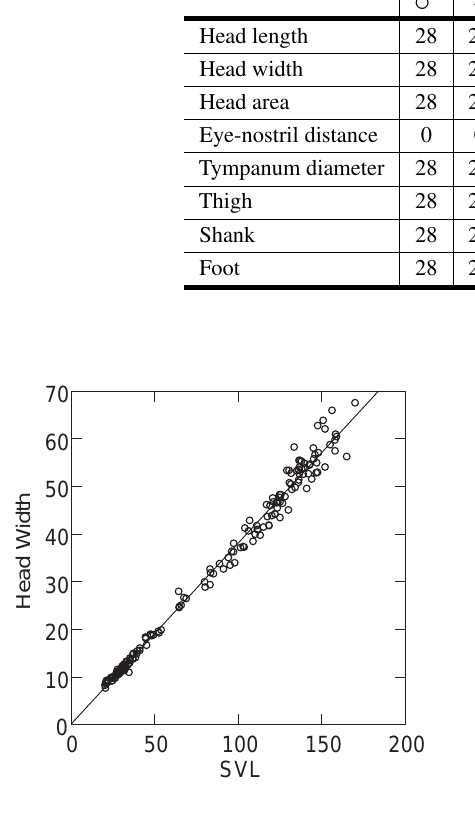
Fig. 5 – Regression of head width on SVL for juvenile and adult male specimens of Leptodactylus knudseni . Adjusted multiple r 2 = 0.989, p = 0.000. Values in mm.